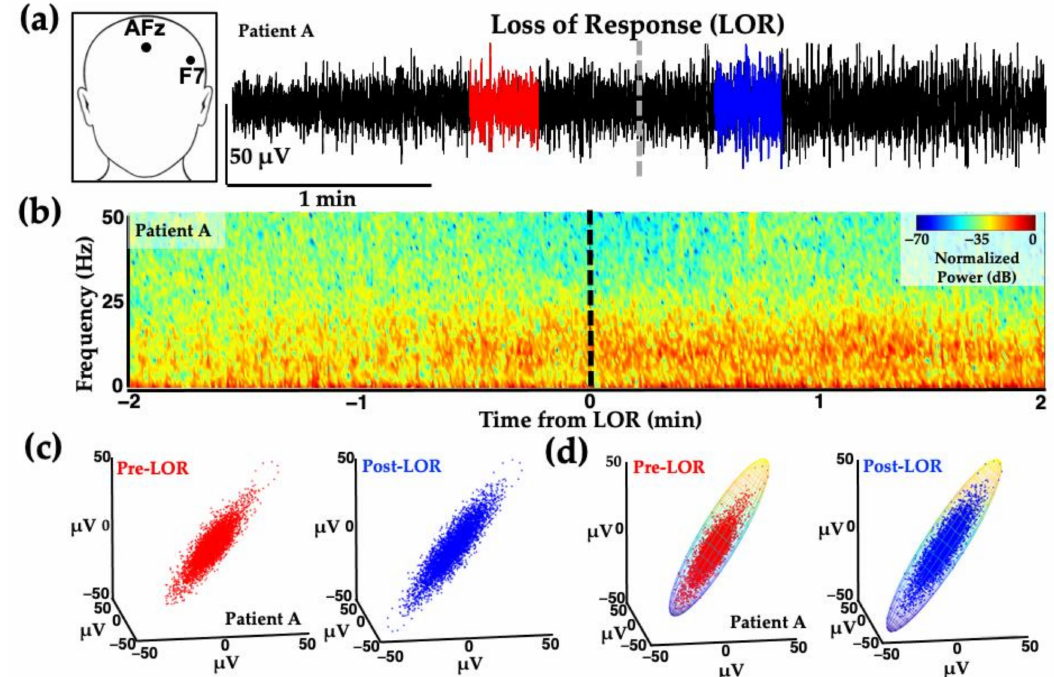
Figure 4. Example of frontal activity from patient EEGs before and after loss of response with propofol. ( a ) EEG activity from electrode location F7 (inset) before (red) and after (blue) loss of response (LOR, indicated with dashed line) in patient anesthetized with a slow infusion of propofol. ( b ) Normalized spectrogram of EEG activity starting from 2 min before to 2 min following LOR. ( c ) Attractors from EEG activity from patients before (red) to after (blue) LOR. Following LOR, a geometric shape change occurs where attractors become more ellipsoidal. ( d ) Same attractors from ( c ), fitted with ellipsoid solid of revolution for subsequent analysis. Reproduced with permission from Reference